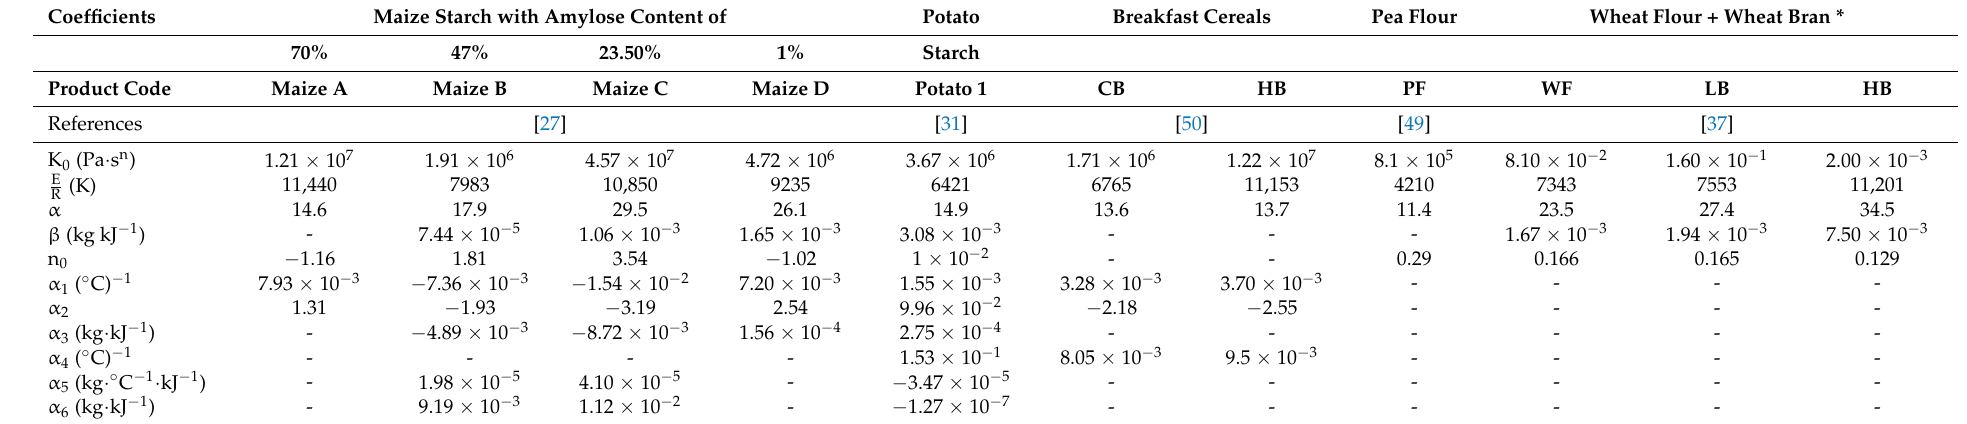
Table 3. Parameters of viscosity model for various molten starchy